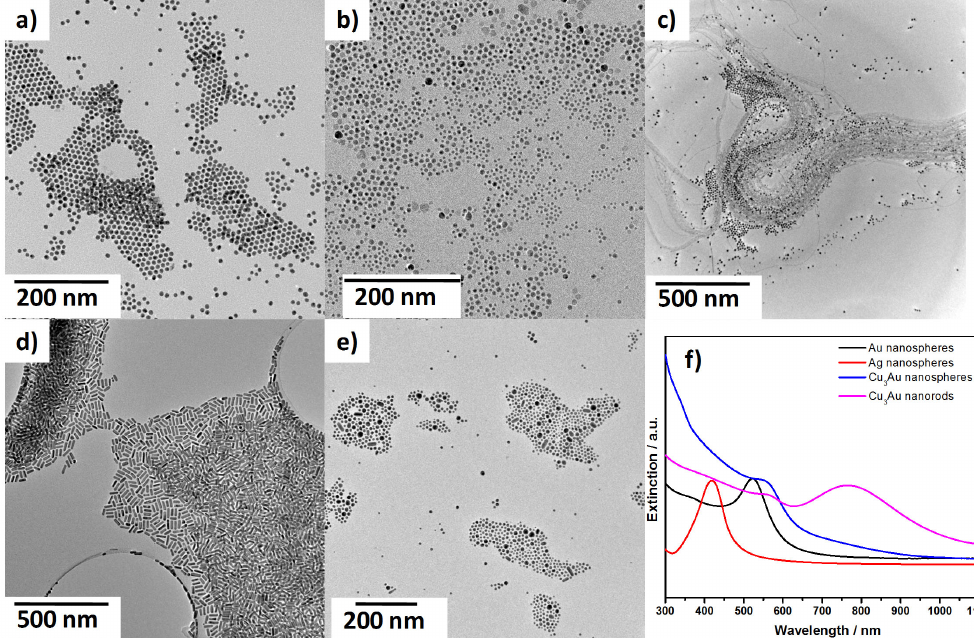
Figure 5 - TEM images of ( a ) Au nanospheres, ( b ) Ag nanospheres, ( c ) ultrathin Au nanowires, ( d ) Cu 3 Au nanorods, and ( e ) Cu 3 Au nanospheres synthesized by thermal decomposition methods. ( f ) the UV-Vis extinction spectra of Au, Ag, Cu 3 Au nanospheres and Cu 3 Au